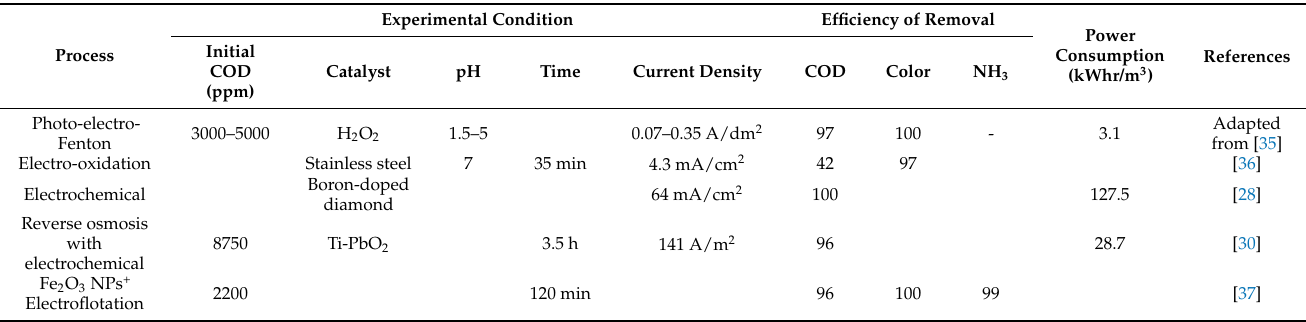
Table 1. The summary of literature review for leachate treatment by different